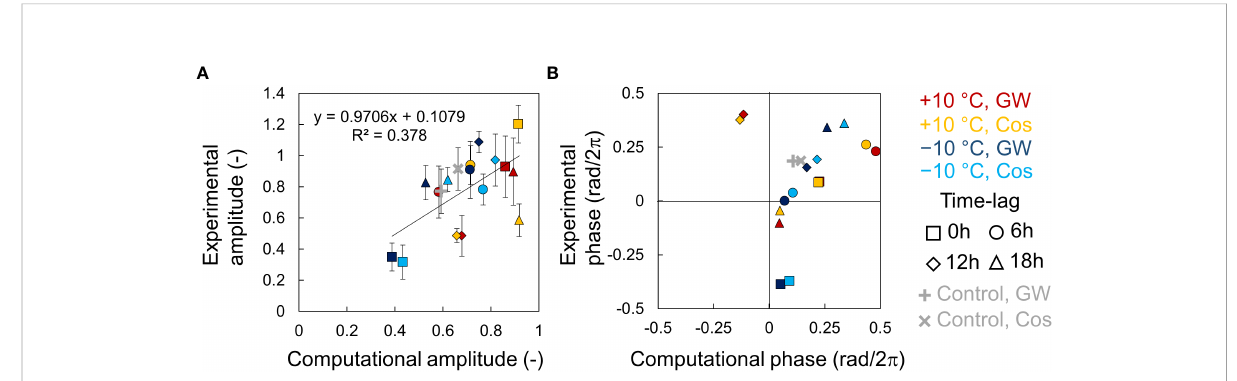
FIGURE 6 Relationship between the AtCCA1 rhythms of leaf lettuce ( Lactuca sativa L.) in the experiments and simulations. (A) Correlation between amplitudes in the experiment and simulation (mean ± SD in experiment). Error bars indicate standard deviation. The solid line indicates a regression line. The value of R 2 indicates the coef fi cient of determination. (B) Correlation between the locking-phases q 1 in the experiment and the simulation (circular mean in